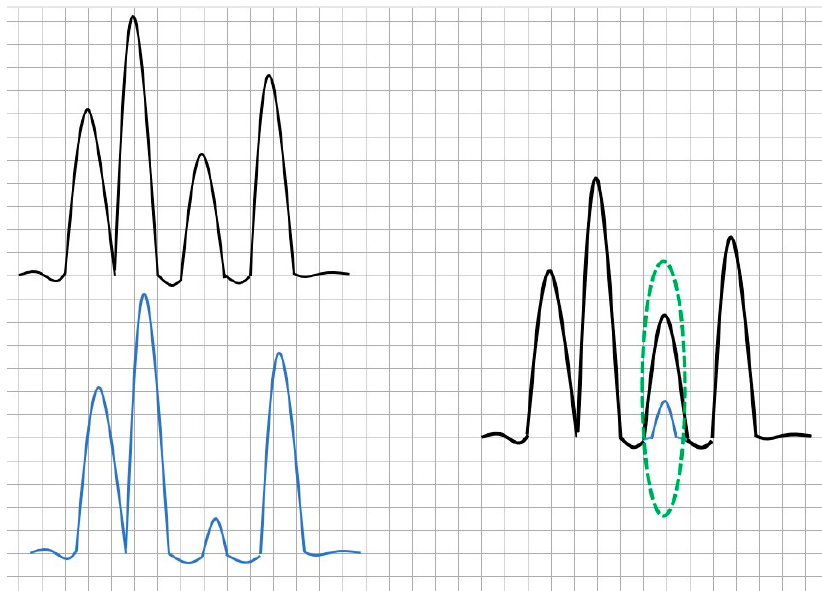
Figure 2. Spectral detection of leak: top left, the theoretical spectrum, and bottom left, the actual detected spectrum; the right feature is the comparison of previous spectra leading to leak detec- tion.